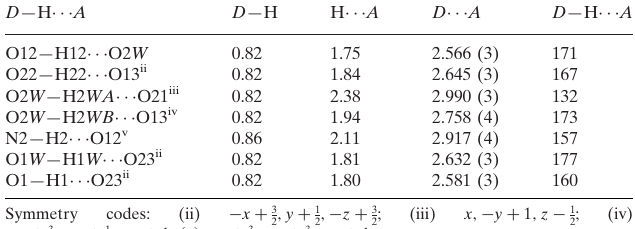
Hydrogen-bond geometry (A˚ , (cid:4)